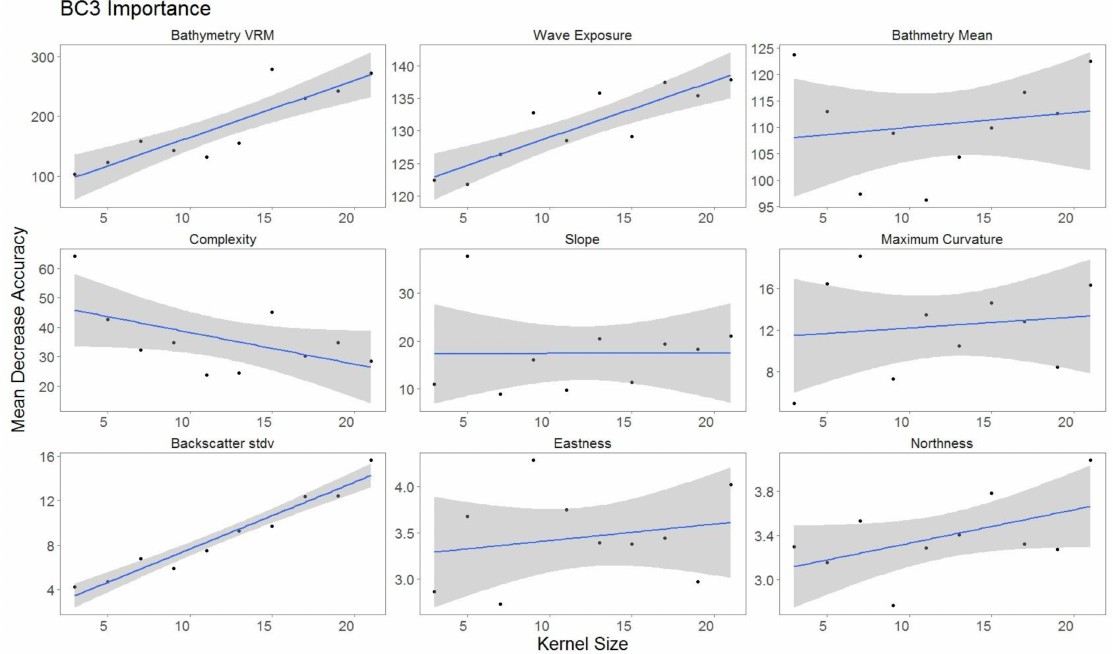
Figure 7. Variable importance for BC3, for variables retained. Sorted by derivatives in order of importance. Generalized linear model (GLM) trend represented in blue. Gray area represents 95% confidence interval for